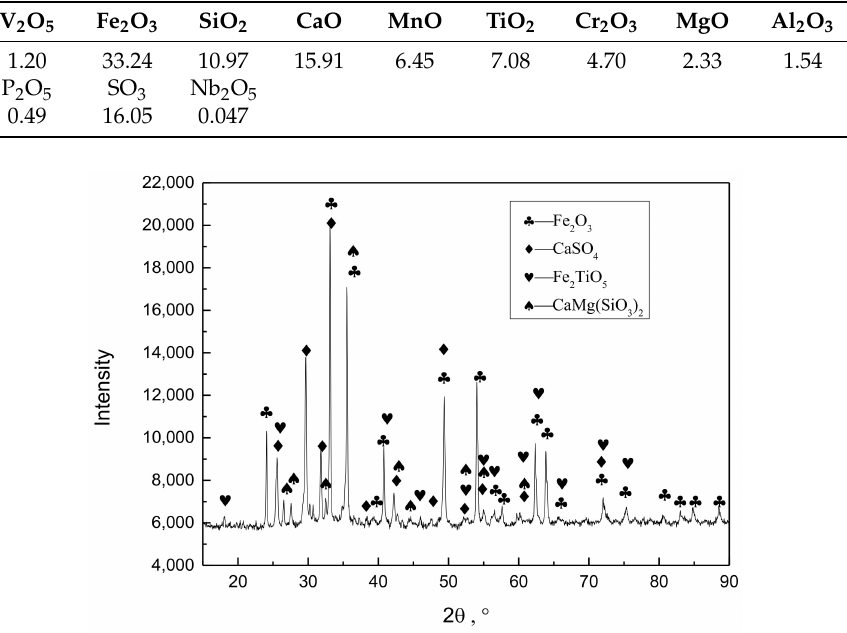
Table 5. Chemical composition of tailings after vanadium extraction with calcified roasting-acid leaching (wt. %).